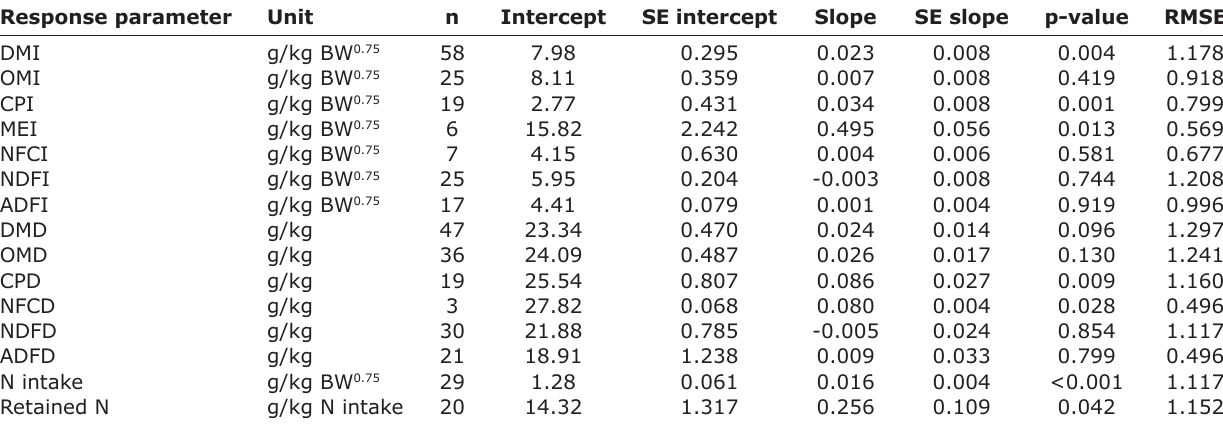
Table-3: Influence of urea supplementation (g/kg DMI) on nutrient intake and digestibility of sheep. Response